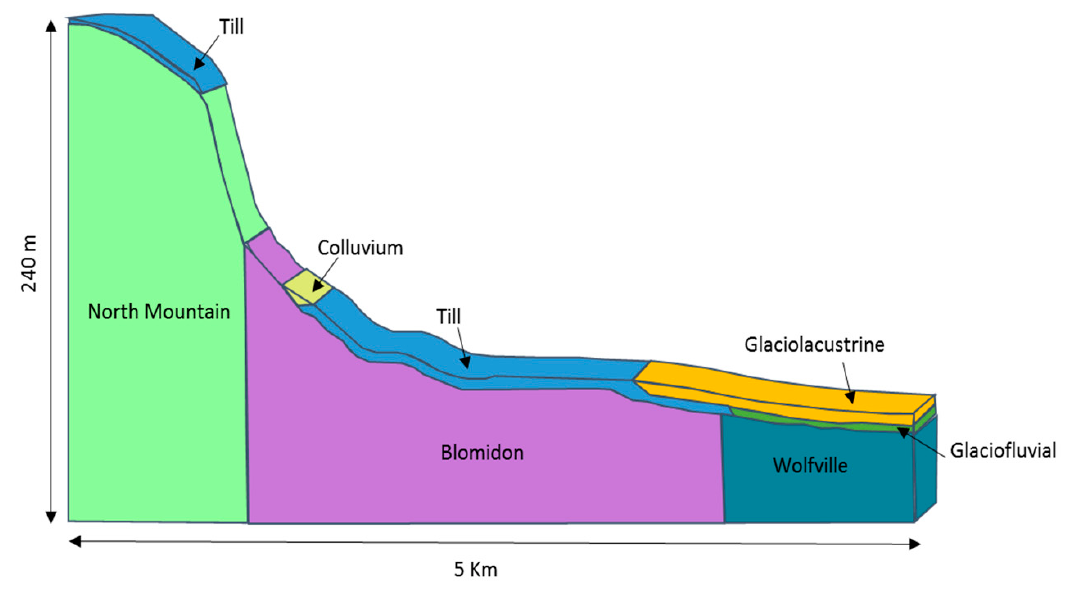
Figure 4. Schematic geologic model of the Thomas Brook catchment (modified after [19]). Table 1. Hydrogeological properties of the formations in the Thomas Brook catchment [19].